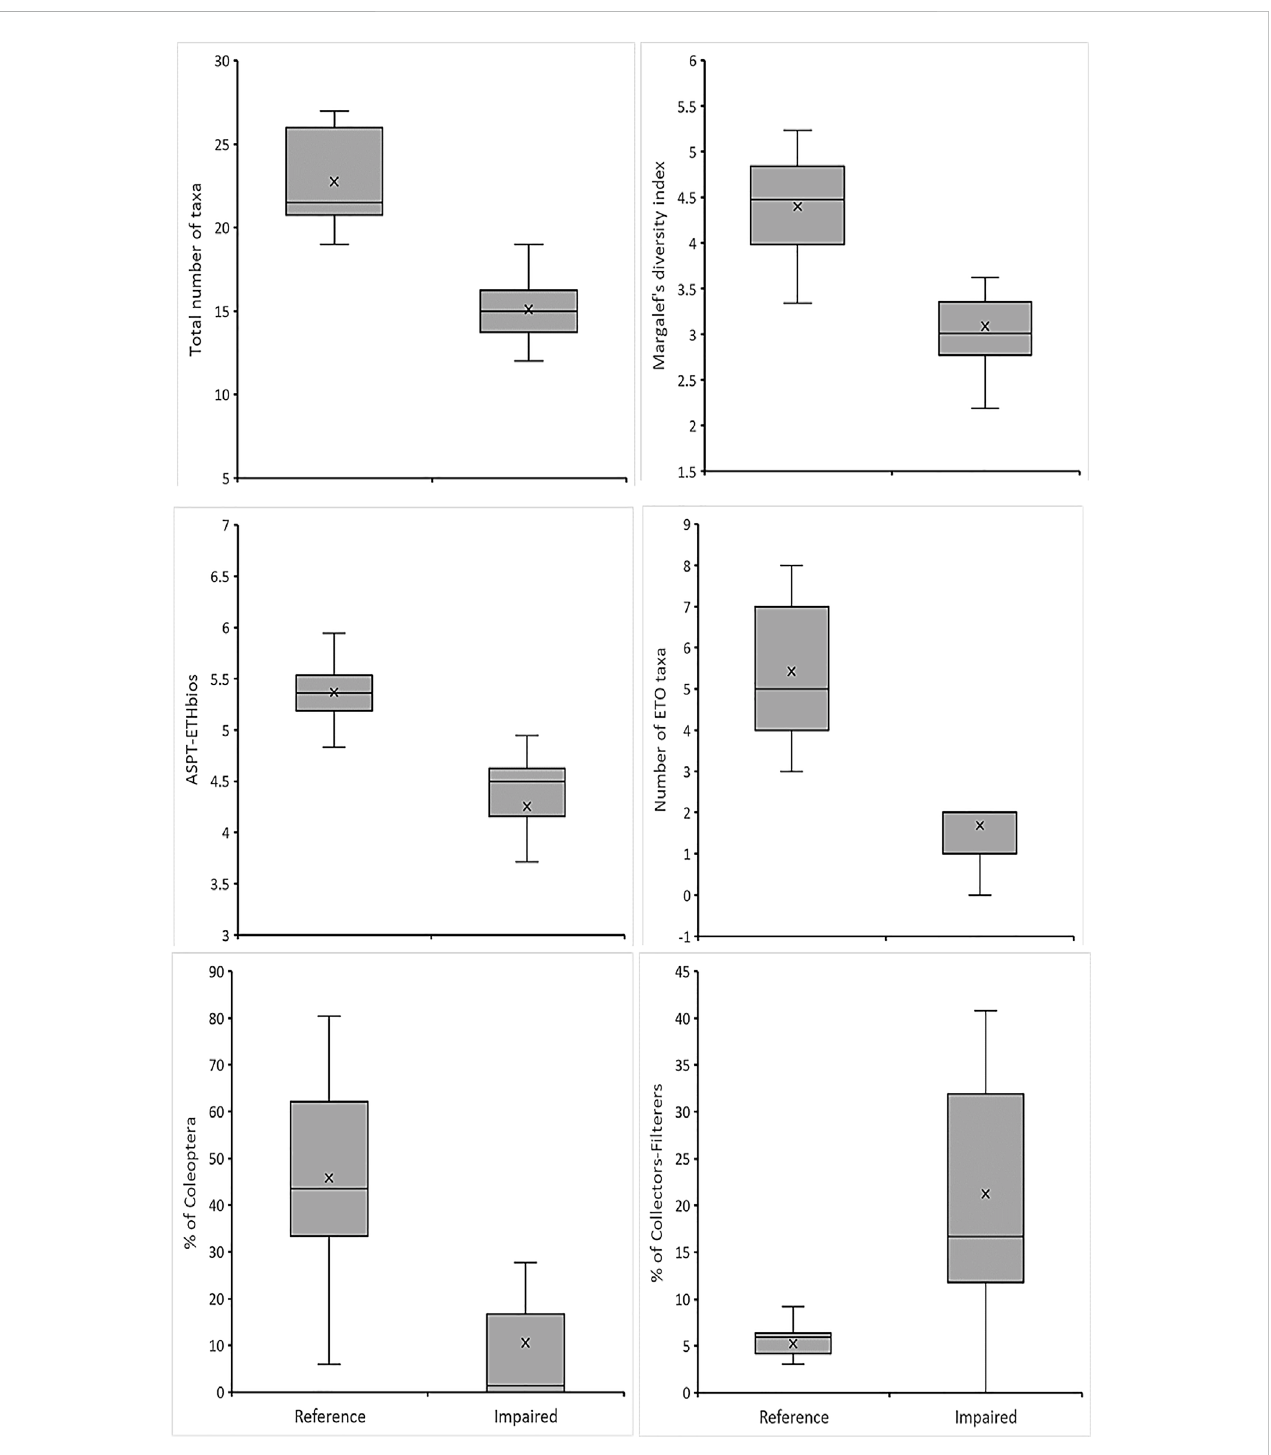
FIGURE 2 Box-Whisker plots of the six-core metrics used to discriminate between reference and impaired 781 wetland sites.